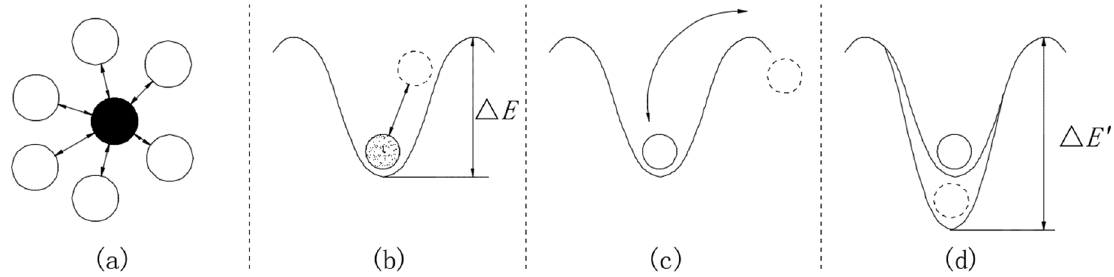
Figure 9. A simple illustration of the thixotropic behavior of CPB. ( a ) The particle interaction forces determine for each particle a potential energy well. ( b ) The particle does not leave the well. ( c ) The particle has the ability to get out of the well. ( d ) The potential energy well tends to be deeper at rest with time, the particle needs a larger amount of energy to get out of the well.